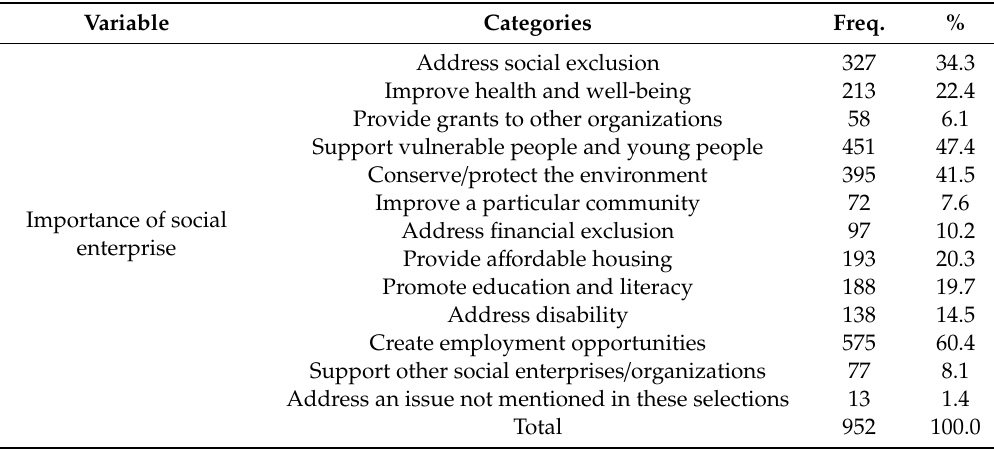
Table 1. Frequency of awareness of the social